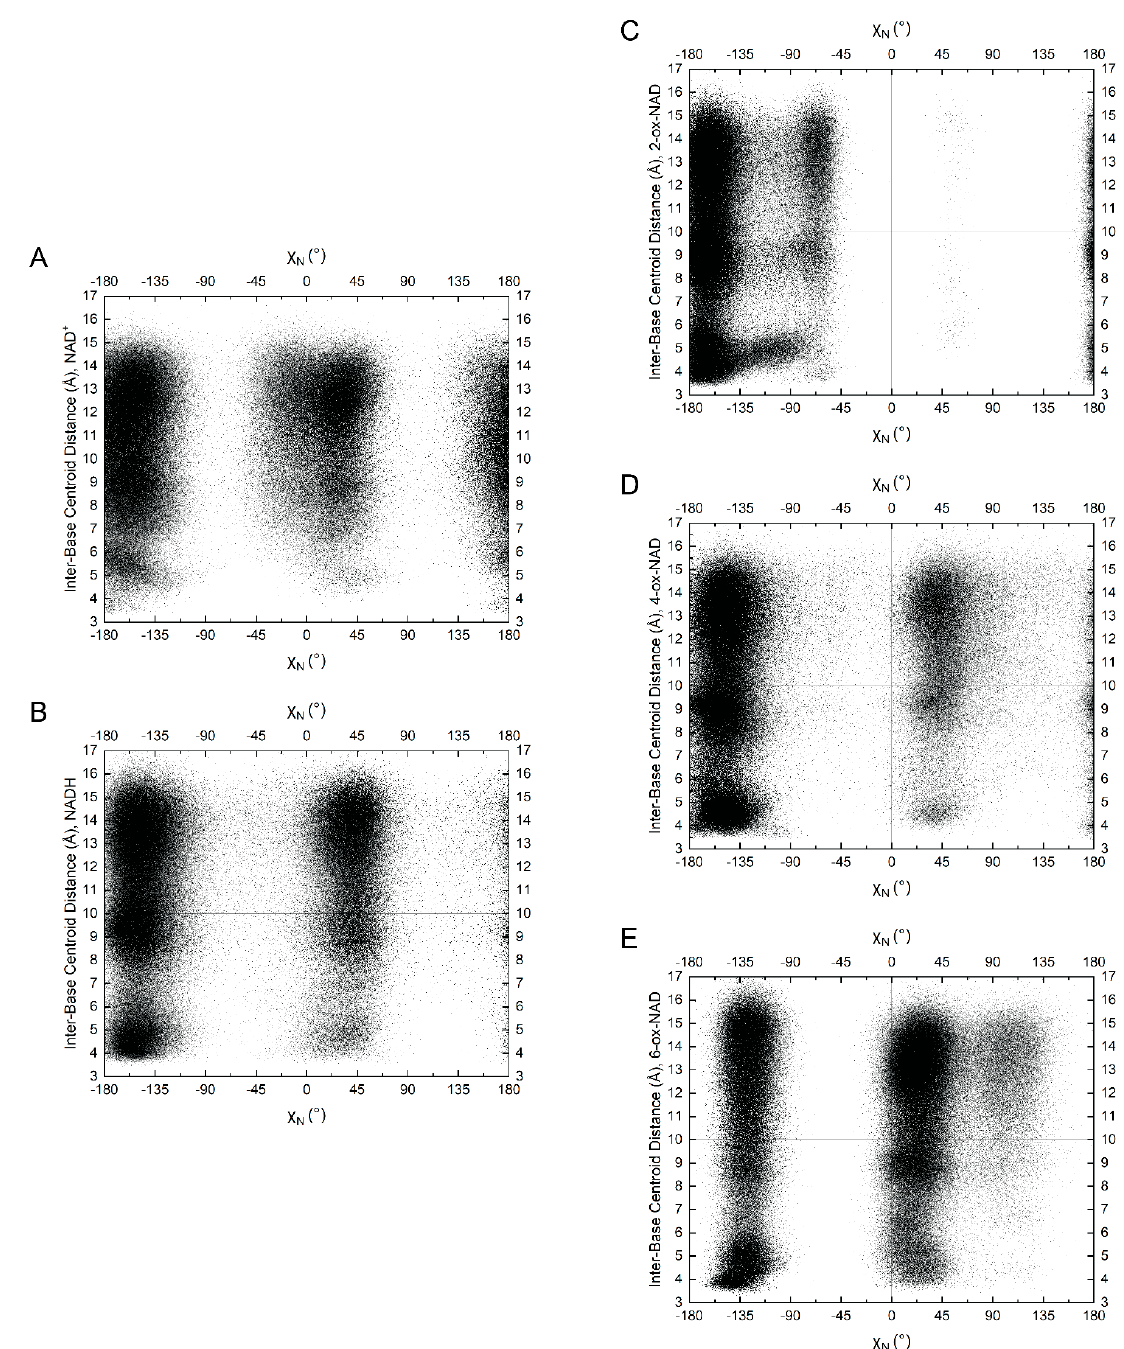
Figure 9. Scatter plot of the inter-base distance versus the nicotinamide/pyridone glycosidic bond dihedral angle ( χ N ) for ( A ) NAD + , ( B ) NADH, ( C ) 2-ox-NAD, ( D ) 4-ox-NAD, and ( E ) 6-ox-NAD. Ox-NADs have the potential to bind to enzymes and thus act as inhibitors. The comparison of the conformational preferences of ox-NADs in solution to those of pro- tein-bound NAD(H) provides insight into proteins potentially targeted by ox-NADs. For